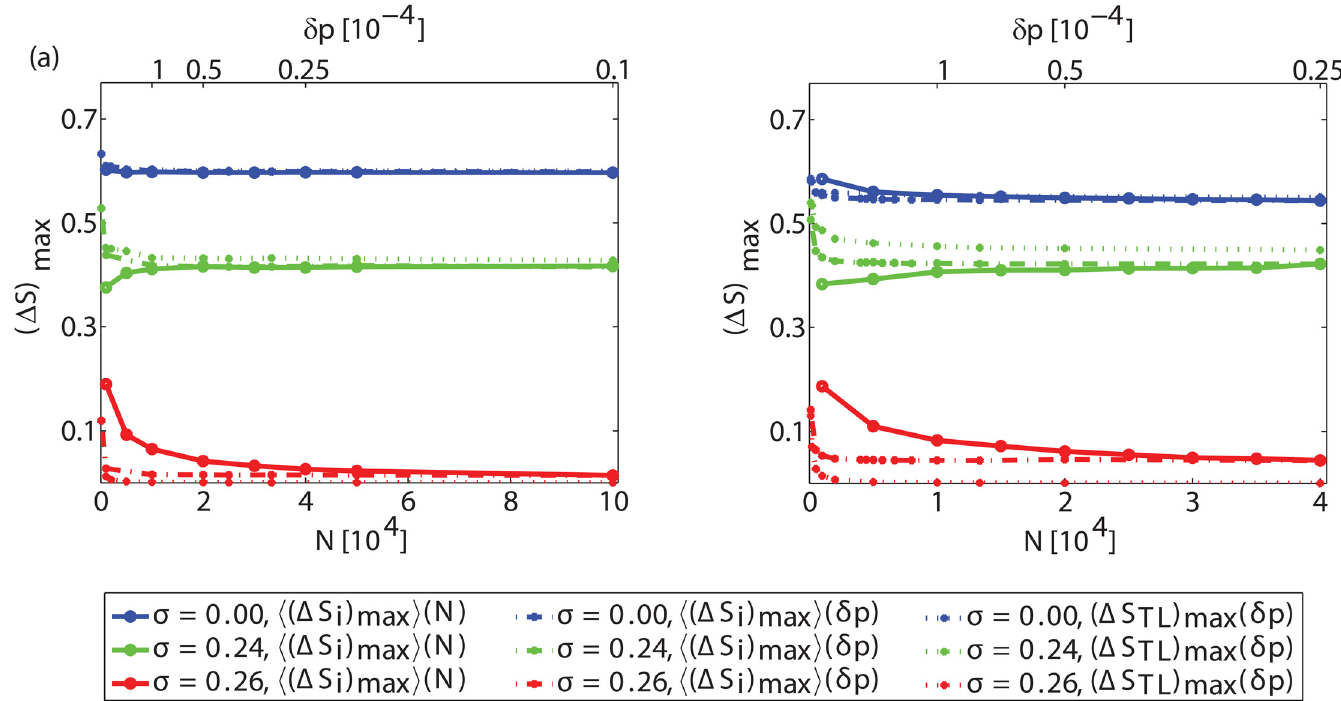
Fig 9. Maximum contribution of initiators to the cascade size for various σ values. (a) for ER graphs and (b) for SF networks with γ = 3, for z = 10. Solid lines: h ( Δ S i ) max i ( N ) of O(1) initiator with one-by-one addition of initiators for varying system sizes (bottom x-axis). Dashed lines: h ( Δ S i ) max i ( δ p ) for various initiator fractions (top x-axis) for a constant system size N = 10 5 . Dotted lines: ( Δ S TL ) max ( δ p ) for various initiator fractions (top x-axis) for the TL approximation. The mean threshold is kept at ϕ 0 = 0.50 in all